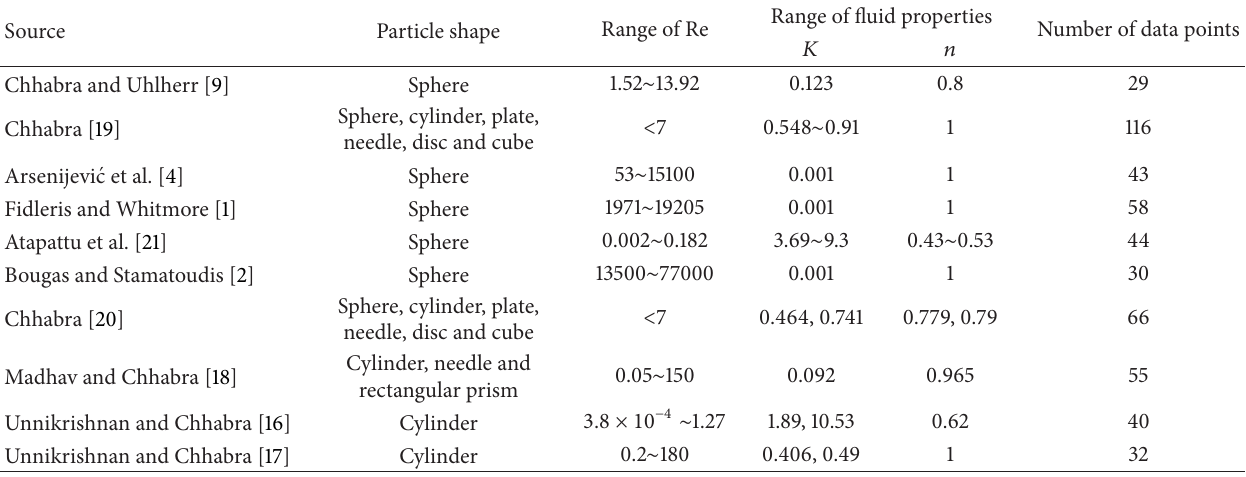
Table 1: Range of conditions covered by the data.